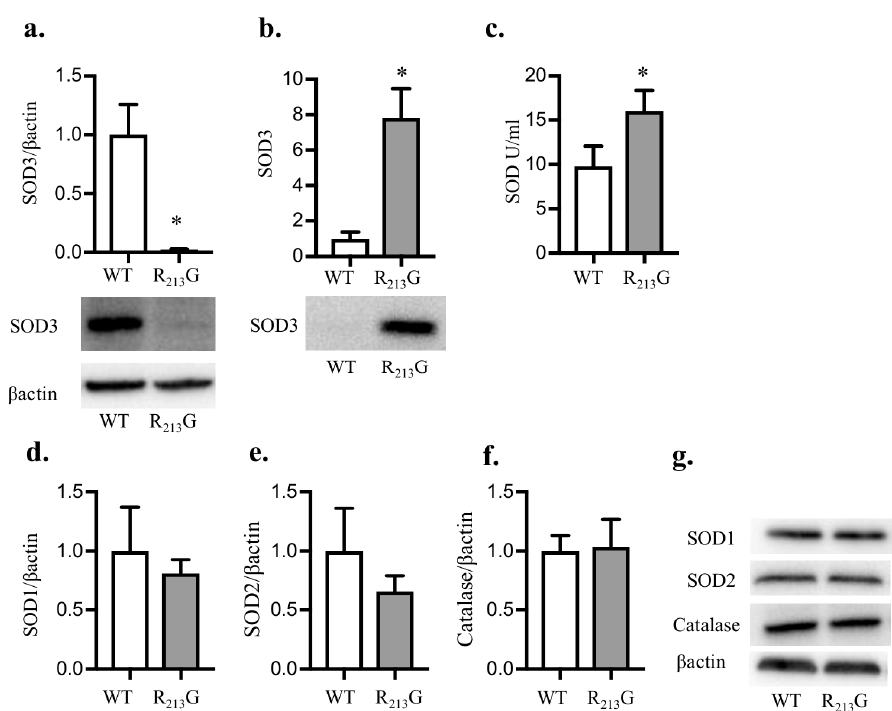
Figure 1. The R 213 G single nucleotide polymorphism (SNP) redistributed superoxide dismutase (SOD3) from the lung into the plasma at 22 days. SOD3 protein content in the lung and serum was evaluated by western blot analysis in control WT and R 213 G mice at 22 days of age. A quantity of 25 µ g lung protein or 2 µ L serum was loaded onto the gels. ( a ) Lung SOD3 ( b ) Serum SOD3. SOD activity in serum was measured using the SOD activity assay (Dojindo). Representative blots are shown below optical density normalized to β -actin and expressed relative to WT mice in Figure 1a,b. ( c ) Serum SOD Activity (units per mL). Several other key antioxidant enzymes were evaluated in the lung by western blot analysis. Representative blots are shown along with optical density normalized to β -actin and expressed relative to WT mice ( d ) Lung superoxide dismutase 1 (SOD1) ( e ) Lung superoxide dismutase 2 (SOD2) ( f ) Lung Catalase. ( g ) Representative blots for SOD1, SOD2, catalase and β -actin are shown).* p < 0.05 vs. WT PBS by unpaired t -test, n = 5–6 for all groups. WT: wild